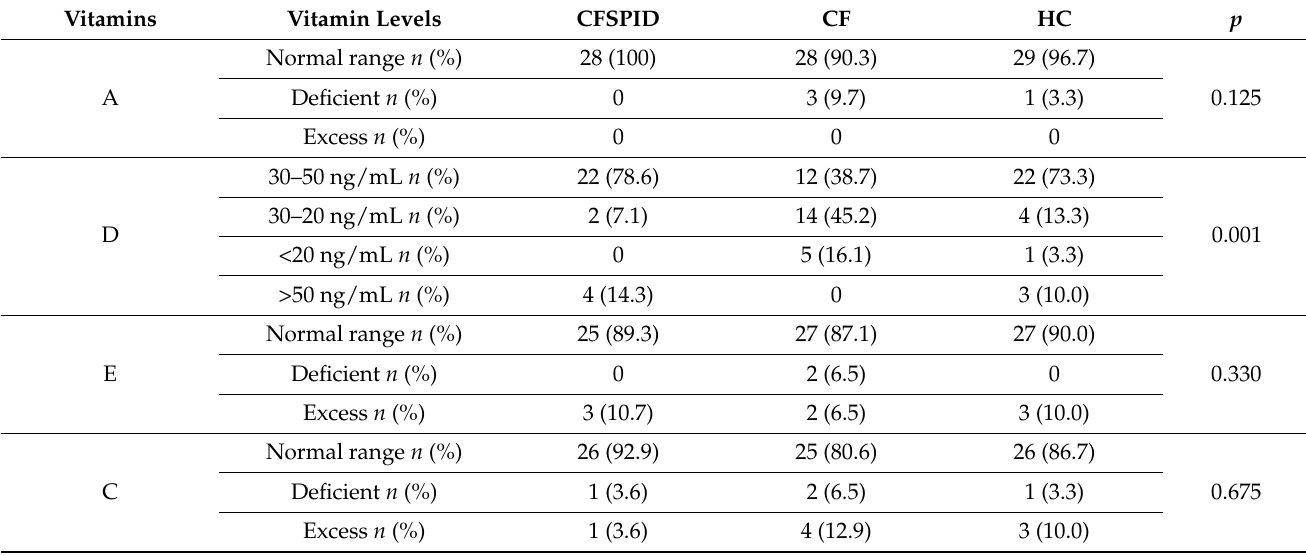
Table 2. Vitamin A, D, E, and C status among children in the study